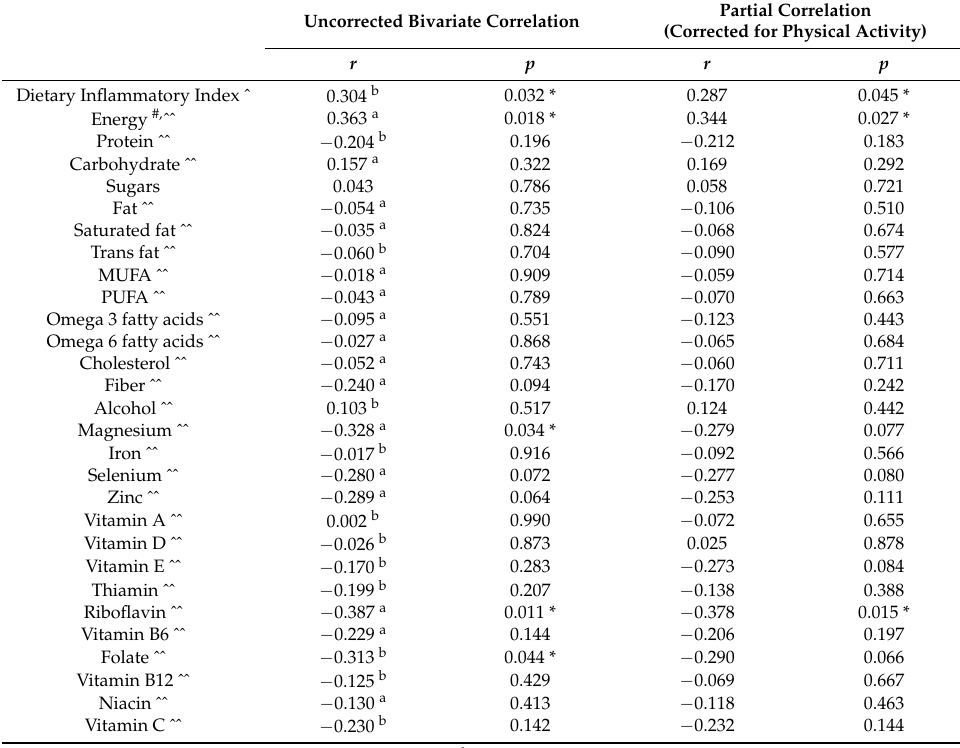
Figure 2. The correlation between dietary inflammatory index and weight regain. Table 3. Correlations between the dietary macronutrient content, the dietary inflammatory index and its components, and weight regain. Uncorrected Bivariate Correlation